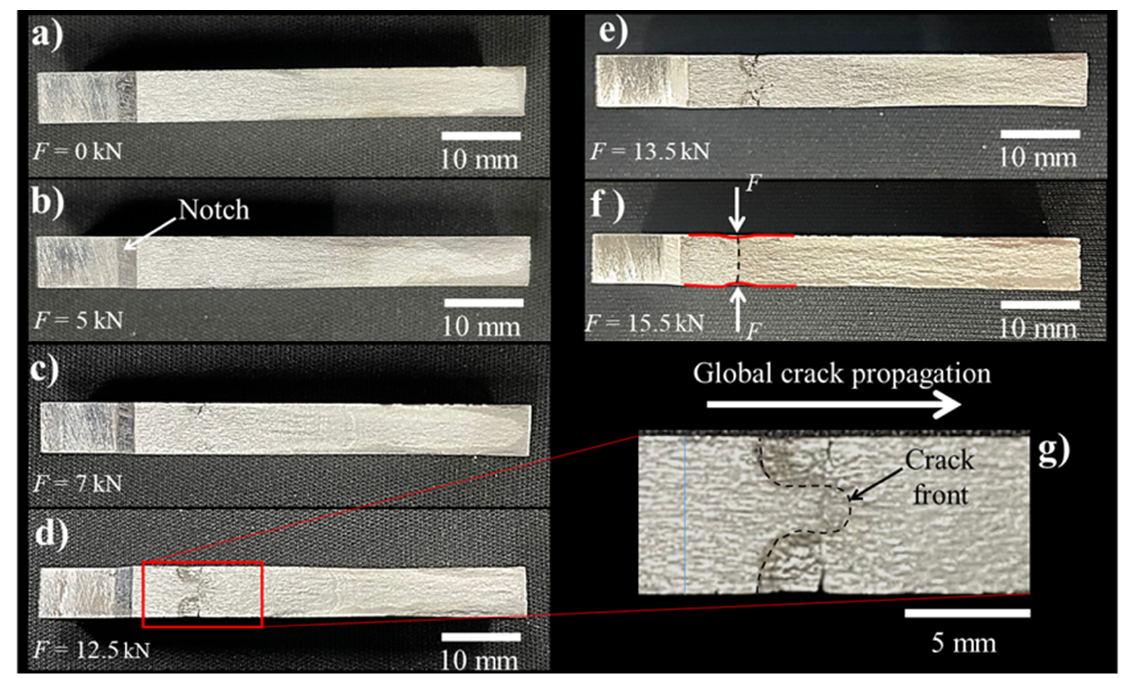
Figure 12. Fracture surfaces of the fatigue crack for the 7075-T651 aluminum alloy, ( a ) base material non-LCD, ( b – f ) different LCD conditions (compressive force from 5.0 to 15.5 kN). Details of the fracture surface taken at different magnifications for the 7075-T651 alu- minum alloy with non-LCD and LCD performed at 12.5 kN are shown in Figures 13 and 14, respectively.